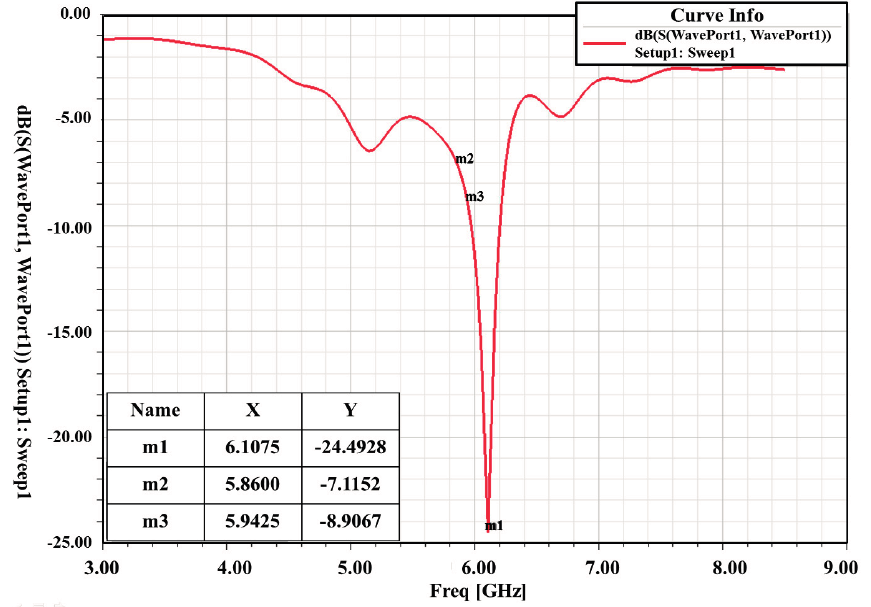
Figure 4. Simulation result of return